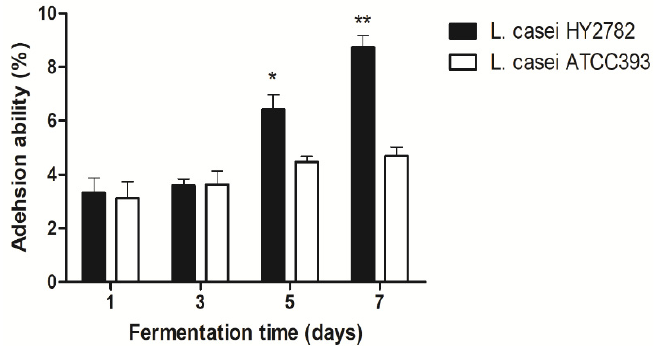
Figure 3. Intestinal adhesion ability of fermented milk with Lactobacillus casei HY2782 and L. casei ATCC393 on HT-29 cells. Different letters above the bars indicate statistically significant differences from each sample on day 1 of fermentation (* p < 0.05, ** p < 0.01).